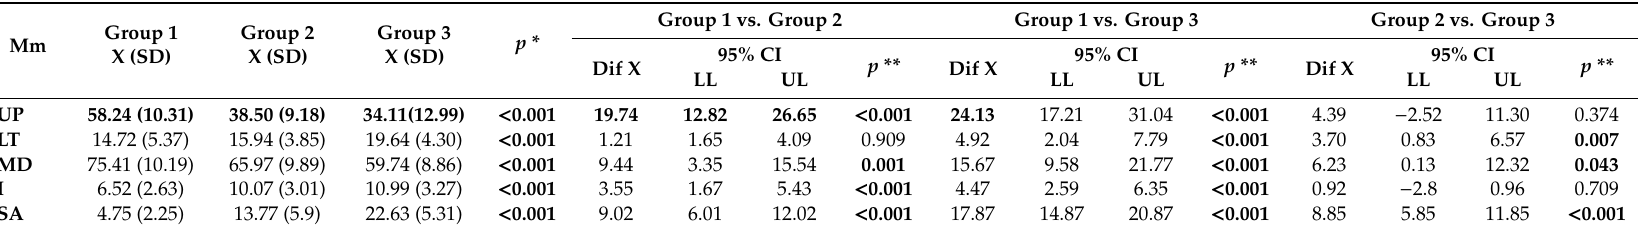
Table 5. The amplitude of muscle activity (RMS%). Abduction movement.